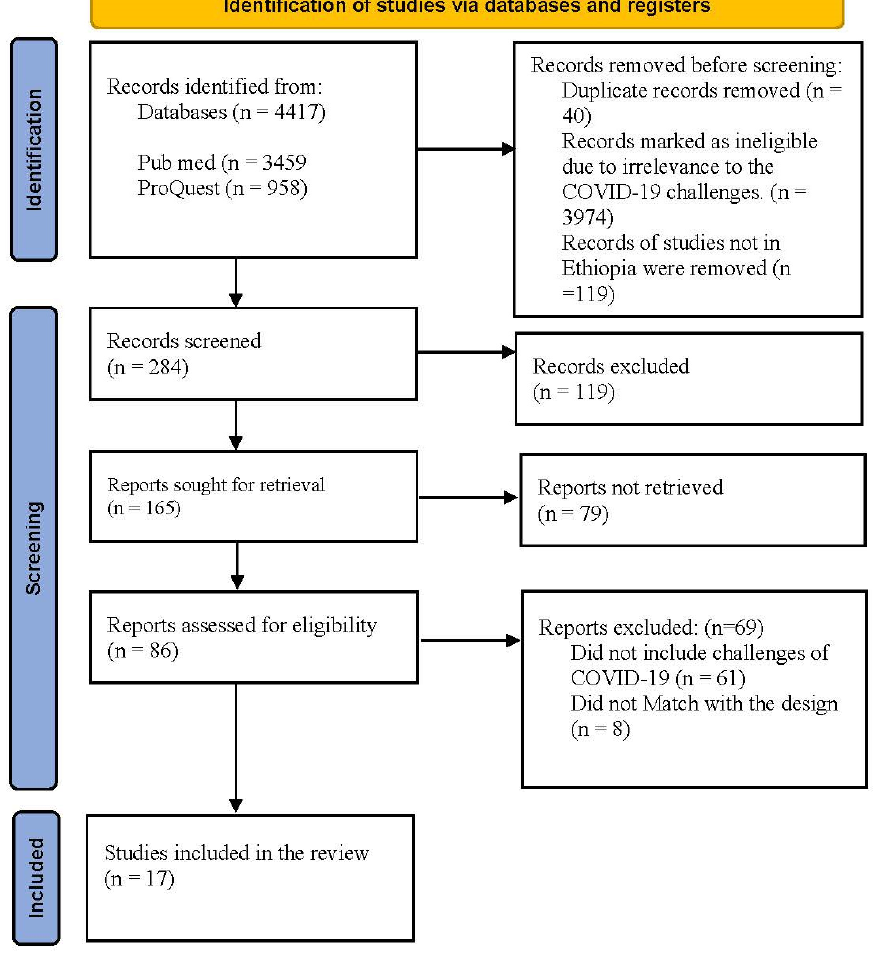
Figure 2. PRISMA model. Table 2. Details of studies included in the review.